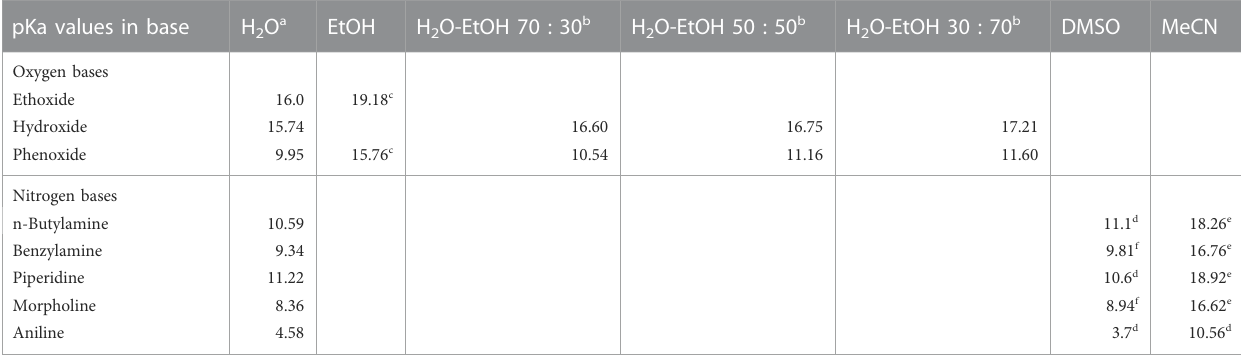
TABLE 3 The p K a values of selected oxygen and nitrogen bases in water, ethanol, various H 2 O-EtOH solvent mixtures, dimethyl sulphoxide, and acetonitrile. pKa values in